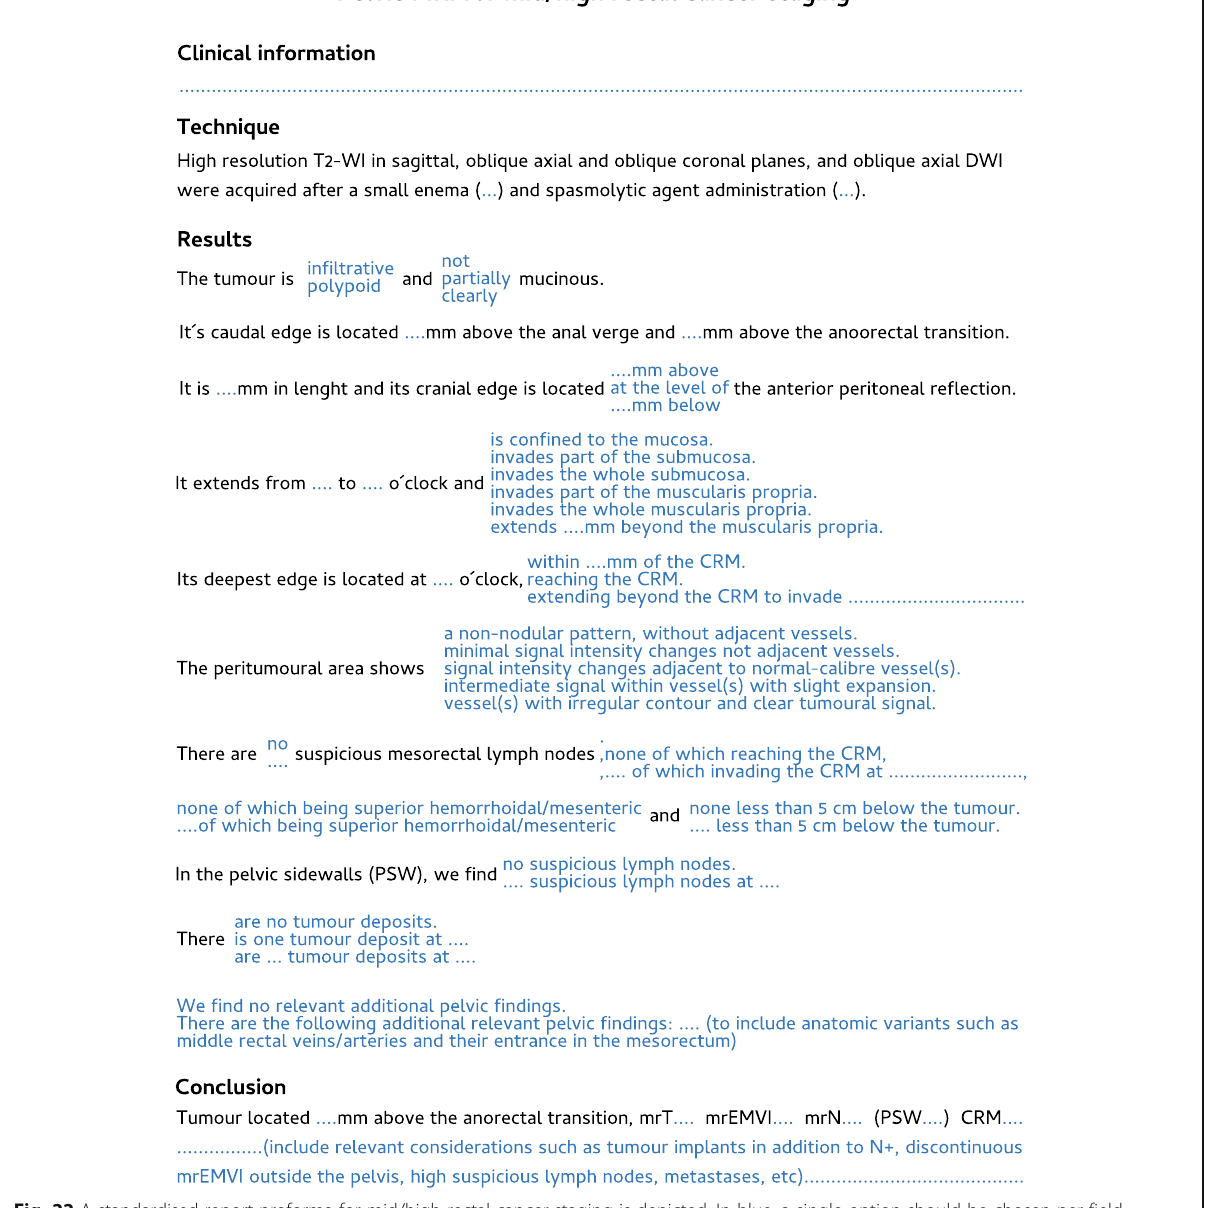
Fig. 22 A standardised report proforma for mid/high rectal cancer staging is depicted. In blue, a single option should be chosen per